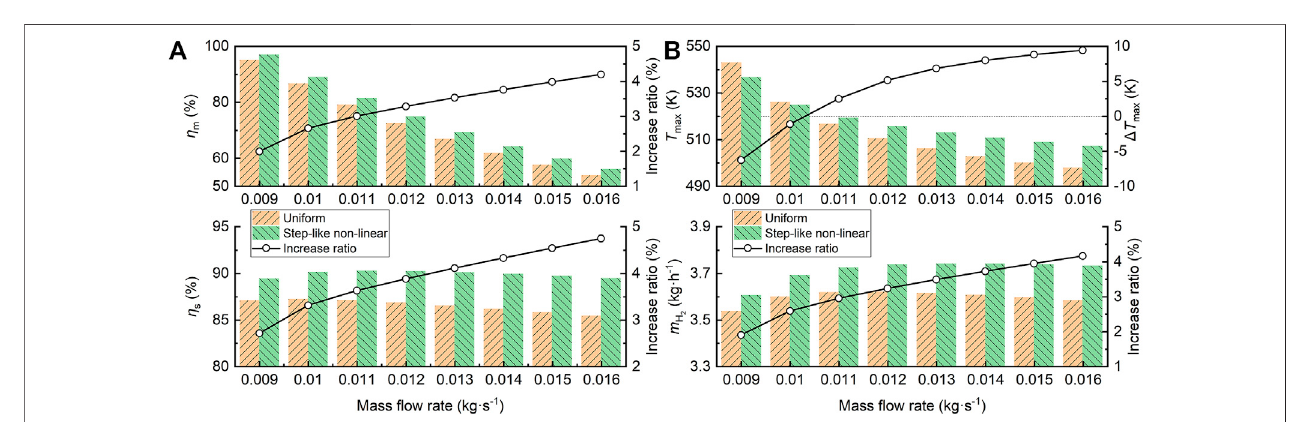
FIGURE 11 | SPTR performance comparison for different reactant mass fl ow rates. (A) η m and η s , (B) T max and m H2 .